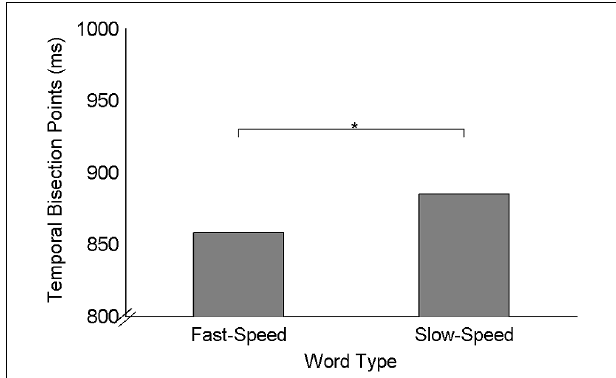
FIGURE 2 | Mean temporal bisection points for two types of speed words. * p <